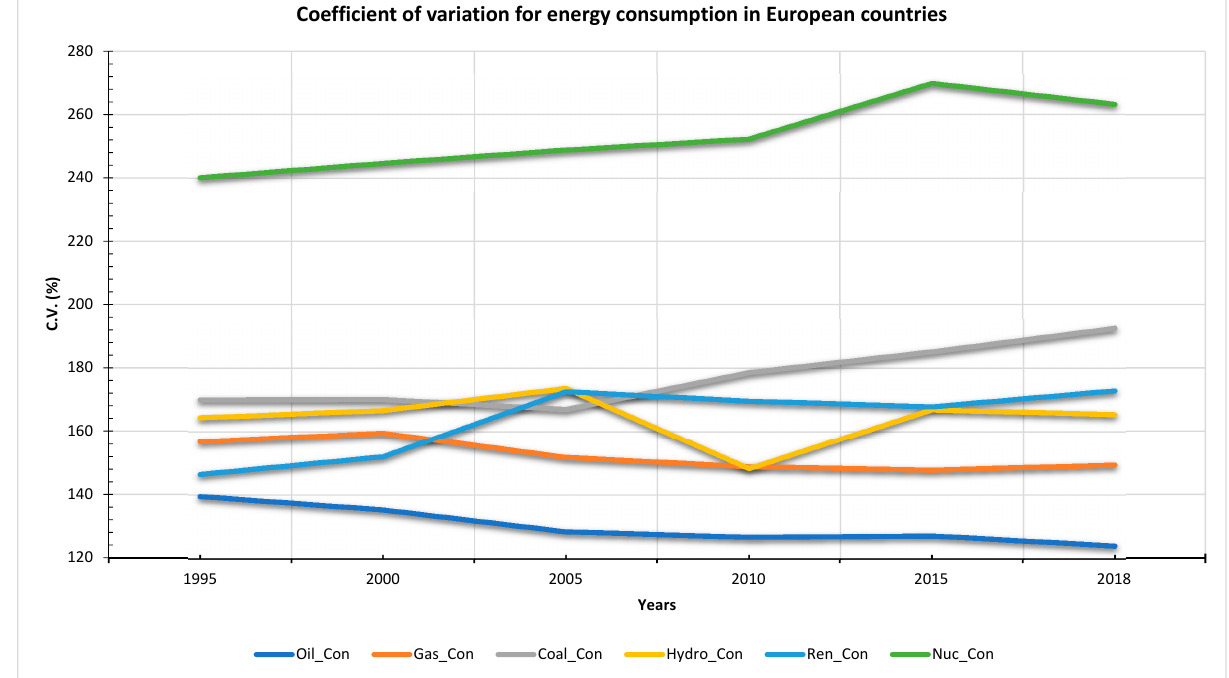
Figure A1. Energy consumption coefficient of variation 1995–2018.